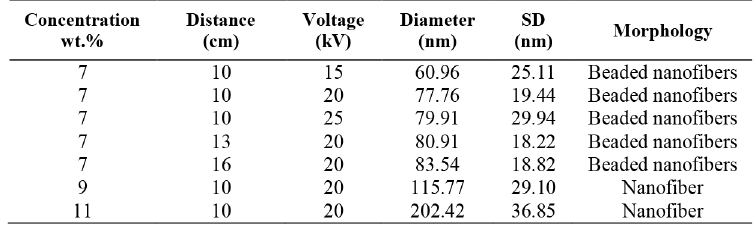
Table 1. Effects of electrospinning parameters on the diameter and morphology of PAN